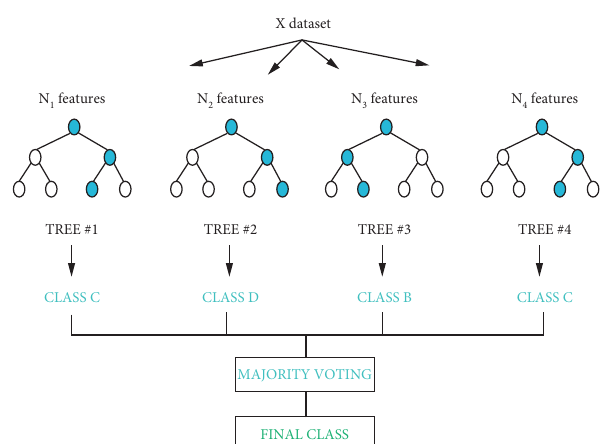
Figure 4: Random Forest first